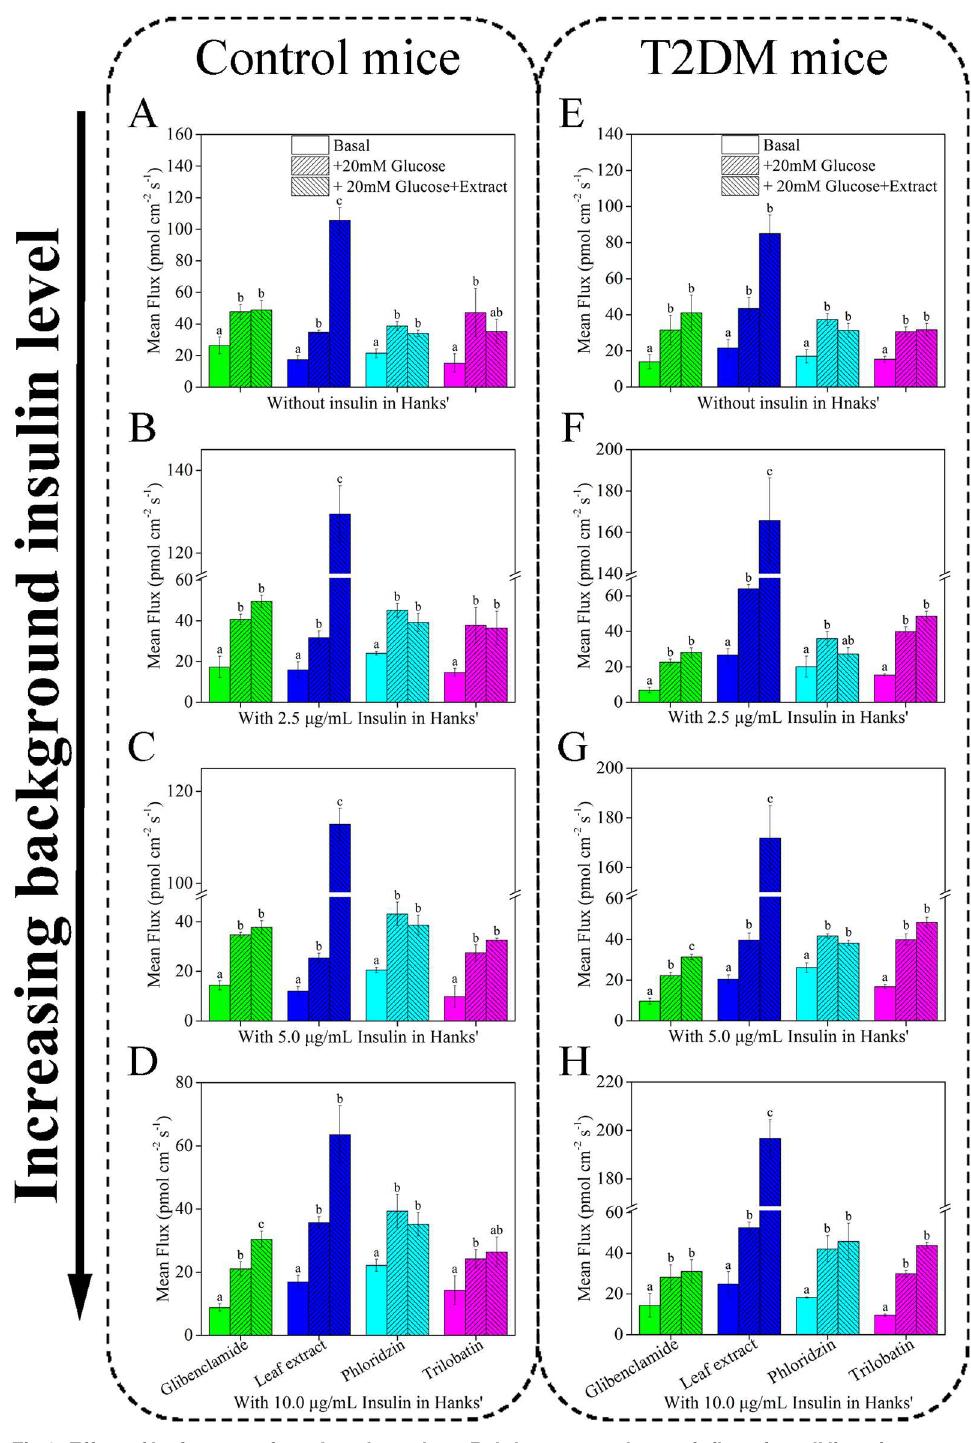
Fig 6. Effect of leaf extractsfrom L . polystachyus Rehd. on mean glucose influx of small liver tissue. A-D shows glucoseinflux of control mice with different level insulinin Hanks’, E-H shows glucoseinflux of experimental T2DM mice. Different colors representfour treatment groups. The data were analyzedwith ANOVA. The values are expressedas the mean ± SEM, n = 6. Columns labeledwith different letters are significantly different at P <